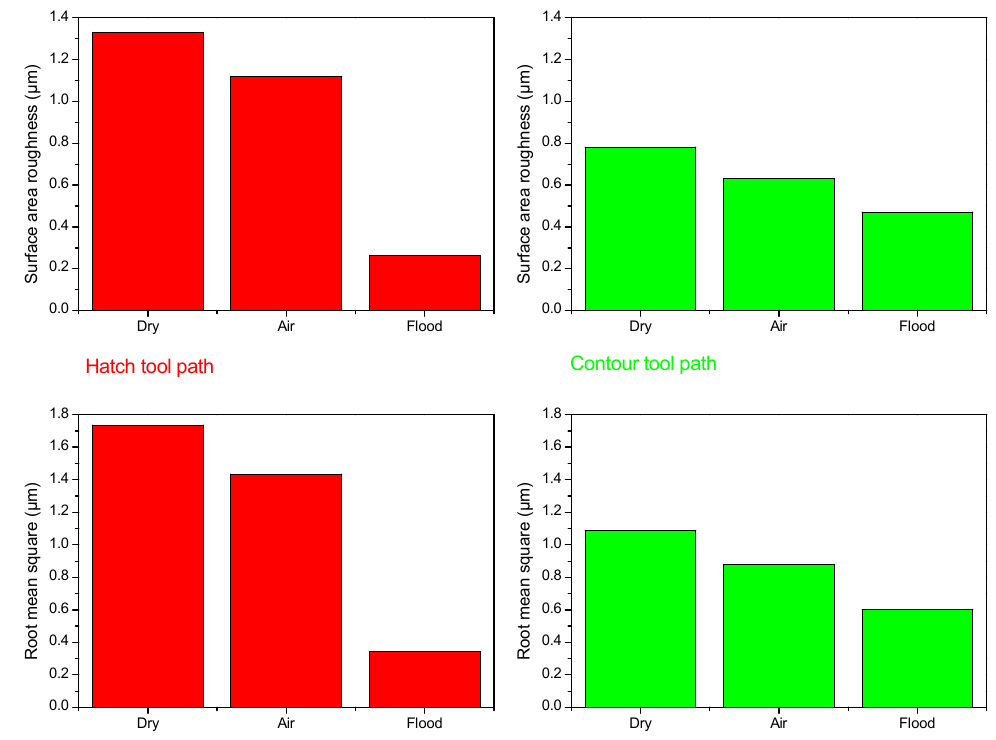
Figure 7. Comparison of roughness values obtained with different milling strategies.